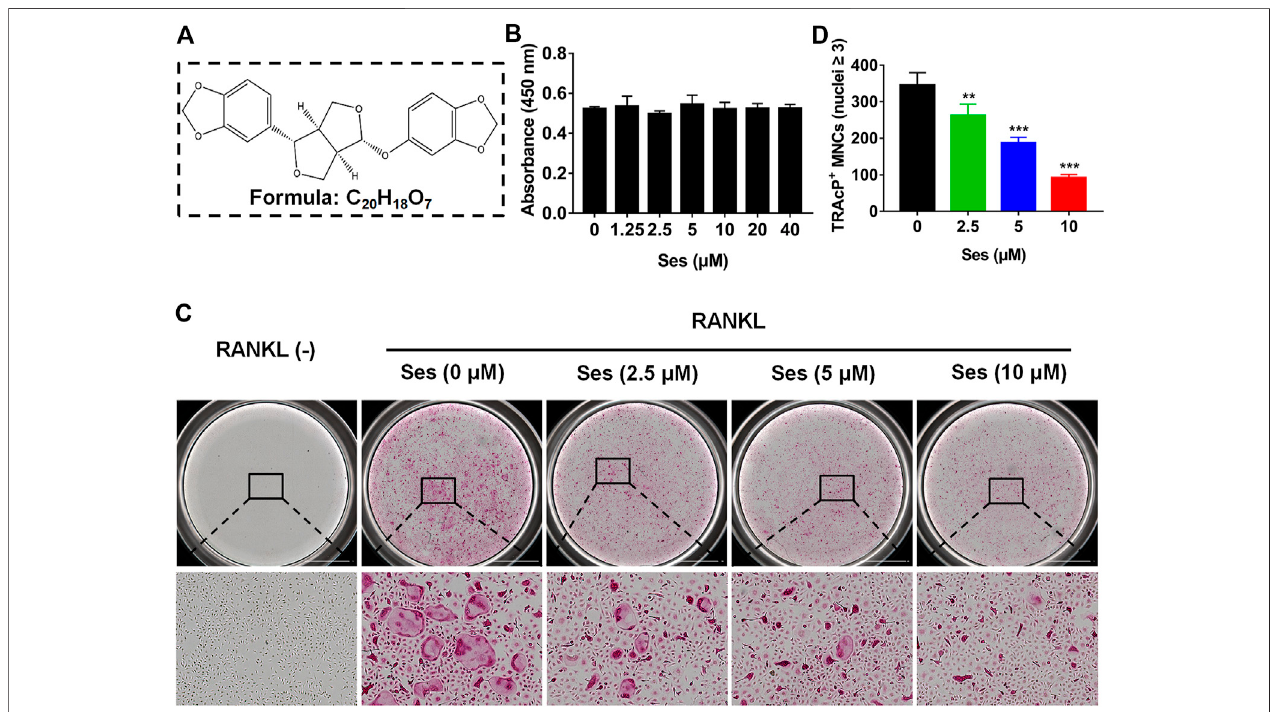
FIGURE 1 | Ses inhibits osteoclast formation induced by RANKL in vitro . (A) The chemical structure and molecular formula of Ses. (B) After 48 h of treatment, the effect of different concentrations of Ses on the viability of BMMs was determined by CCK-8. (C) BMMs were stimulated with RANKL for 5 days, and representative images of TRAcP staining showed that Ses inhibited osteoclast formation in a dose-dependent manner (scale (cid:1) 2,000 μ M). (D) Quanti fi cation of the number of TRAcP- positive multinucleated cells (nuclei ≥ 3). The above data are expressed as the mean ± SD; n (cid:1) 3; ** p < 0.01 and *** p < 0.001. BMMs, bone marrow macrophages; Ses, sesamolin; RANKL, receptor activator of nuclear factor- κ B ligand; TRAcP, tartrate-resistant acid phosphatase.